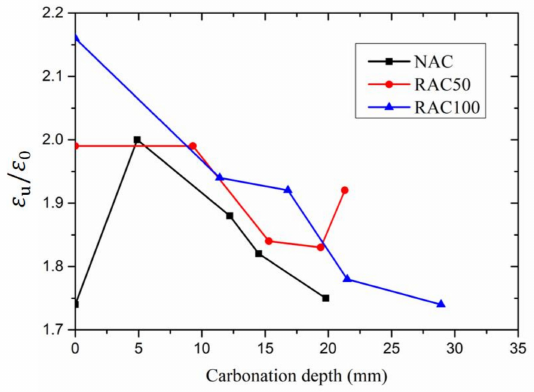
Figure 10. Ratio of ultimate strain to peak strain versus carbonation depth.